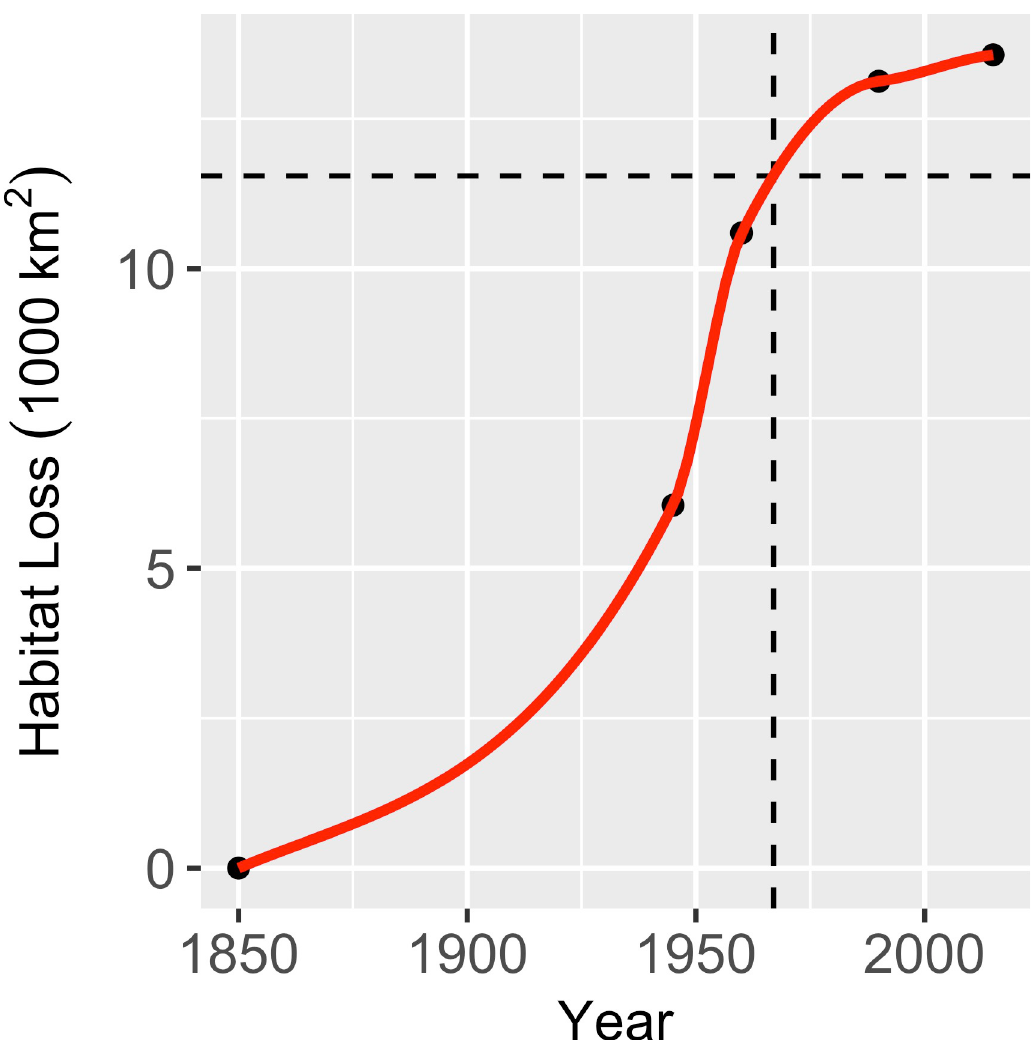
Fig 3. Area of Gambelia sila habitat converted to agricultural and urban development over time. Points are derived from the intersection of historical land use maps and predicted historical distribution. The red line is interpolated with LOESS regression. Dashed lines correspond to the year 1967, when the species became federally